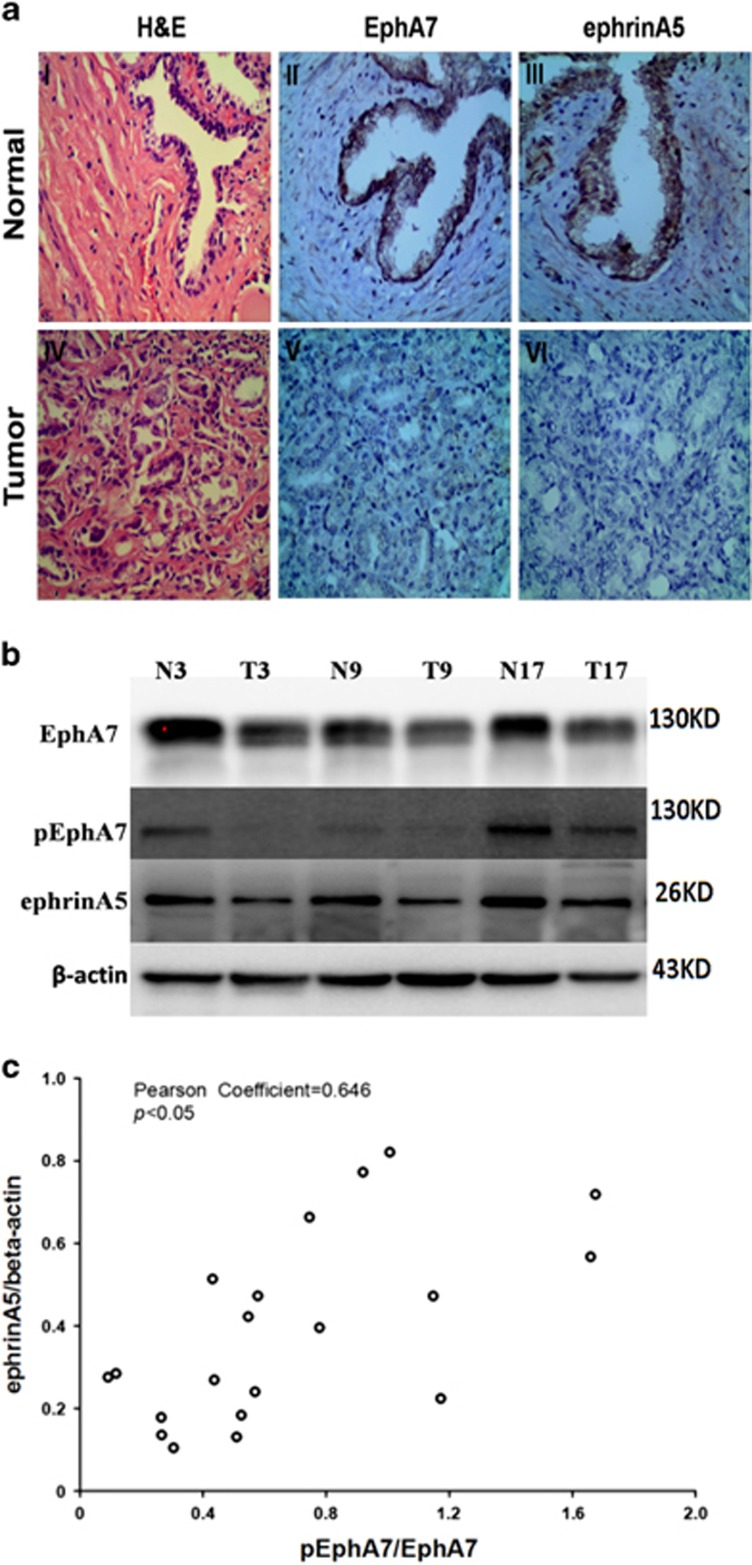
The phosphorylation of EphA7 receptor and the expression of EphA7 and ephrinA5 in human prostate tissues. (a) Representative photographs of EphA7 and ephrinA5 immunostaining in prostate tissue. (I–III) The adjacent non-cancerous prostate tissue. (IV–VI) The prostate carcinoma tissue (magnification, × 400). (b) Representative phosphorylation analysis of EphA7 receptors and the expression of EphA7 and ephrinA5 in human prostate tissues. (c) pEphA7/EphA7 correlates with ephrinA5 expression. Data are shown as the mean±S.D.